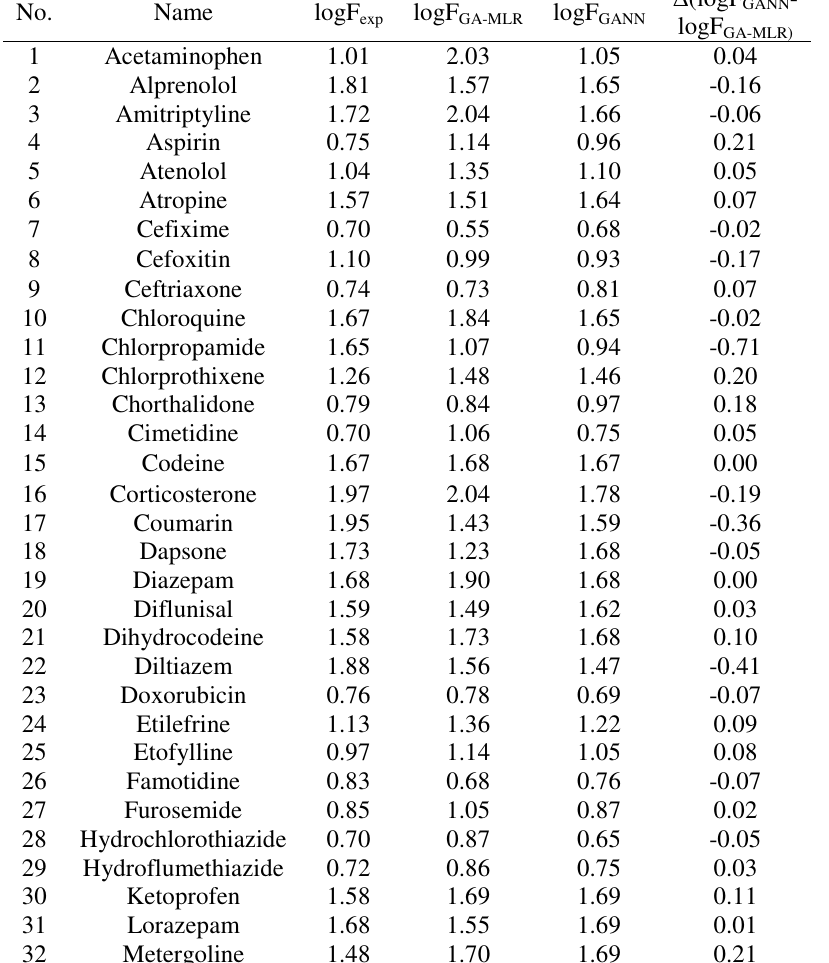
Table 1. Data set and corresponding observed, GA-MLR and GA-ANN predicted values of logF